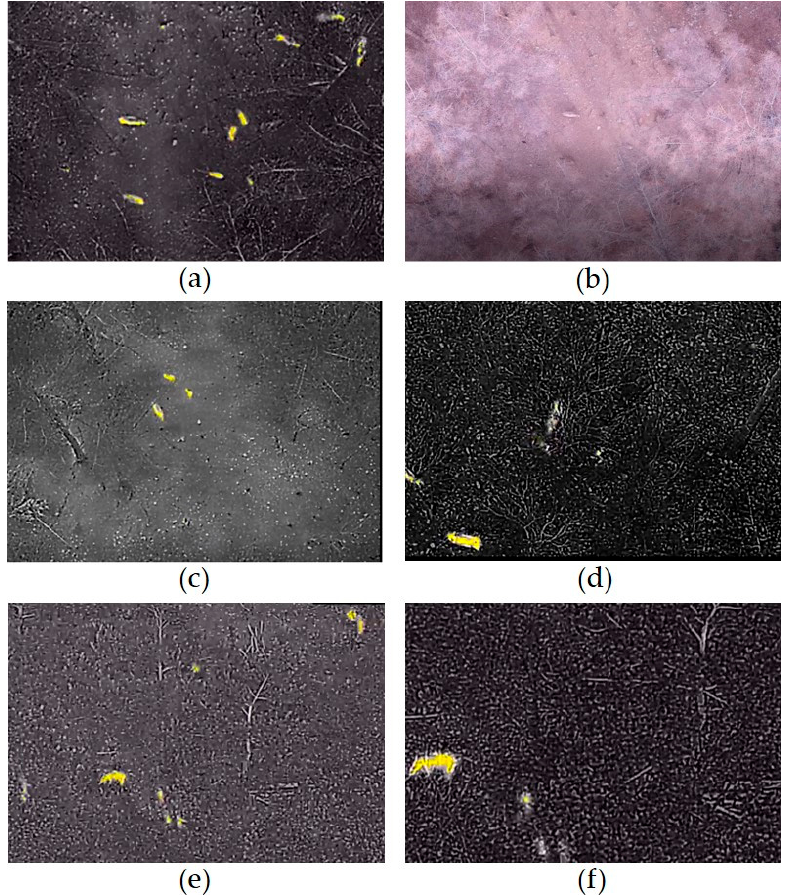
Figure 10. Acquired images during wild boar monitoring from thermal imaging camera and a normal RGB camera using the point count survey method. Note that, when using the point count survey method, the wild boar silhouette is more clearly visible than other methods due to the camera angle adjustment. ( a ) Wild boar silhouette shot with a thermal imaging camera at 50 m altitude with 2× magnification. ( b ) Wild boar shot simultaneously with a regular RGB camera at 50 m altitude with 2× magnification. Wild boar silhouette shots with a thermal imaging camera ( c ) at 60 m altitude with 2× magnification, ( d ) at 60 m altitude with 4× magnification, ( e ) at 70 m altitude with 4× magnification, and ( f ) at 70 m altitude with 8× magnification, respectively.